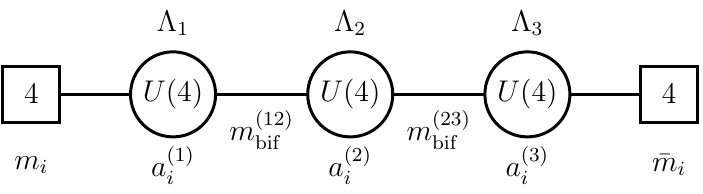
are the exponen- i